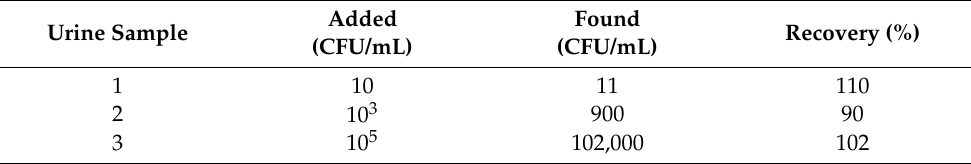
Table 1. Spike sample of E. coli in urine samples with recovery value (%). Urine